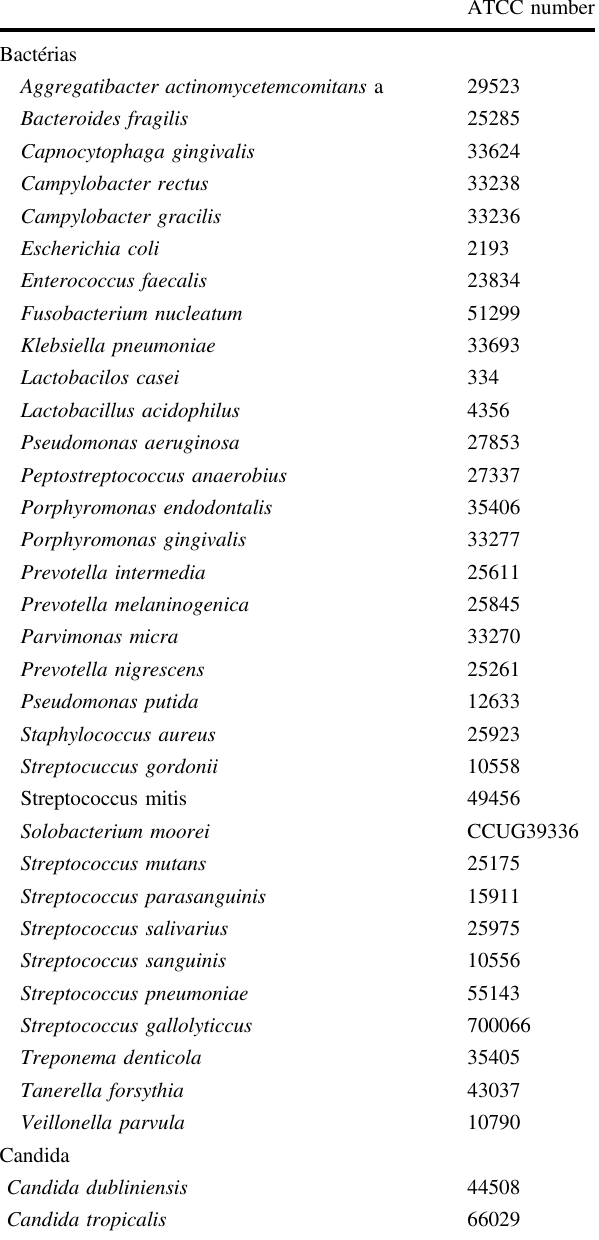
Table 1 Microbial species (and respective ATCC number) used for preparation of the target-speci fi c DNA